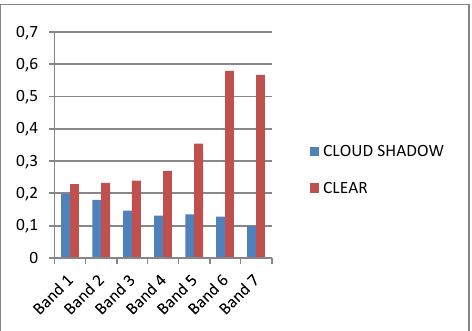
Figure 5. The difference of reflectance values between clear pixels and cloud shadow contaminated pixels on settlement.